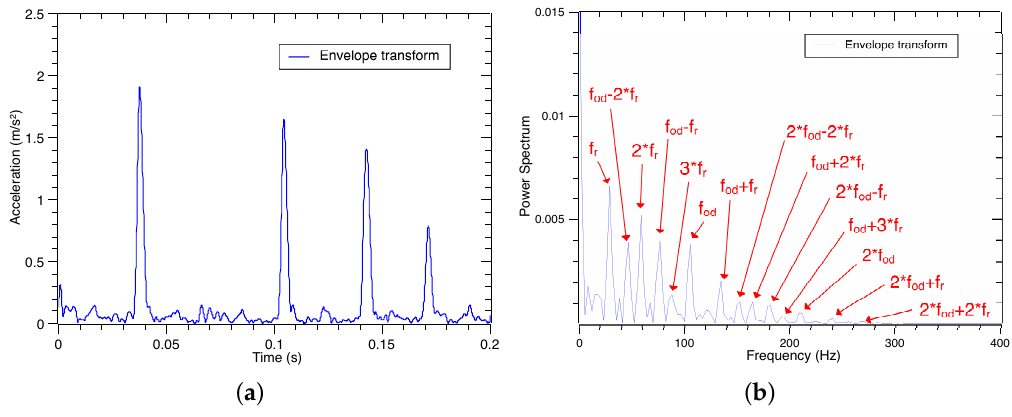
Figure 7. The envelope waveform and spectrum of the third decomposed sub-signal under the outer race